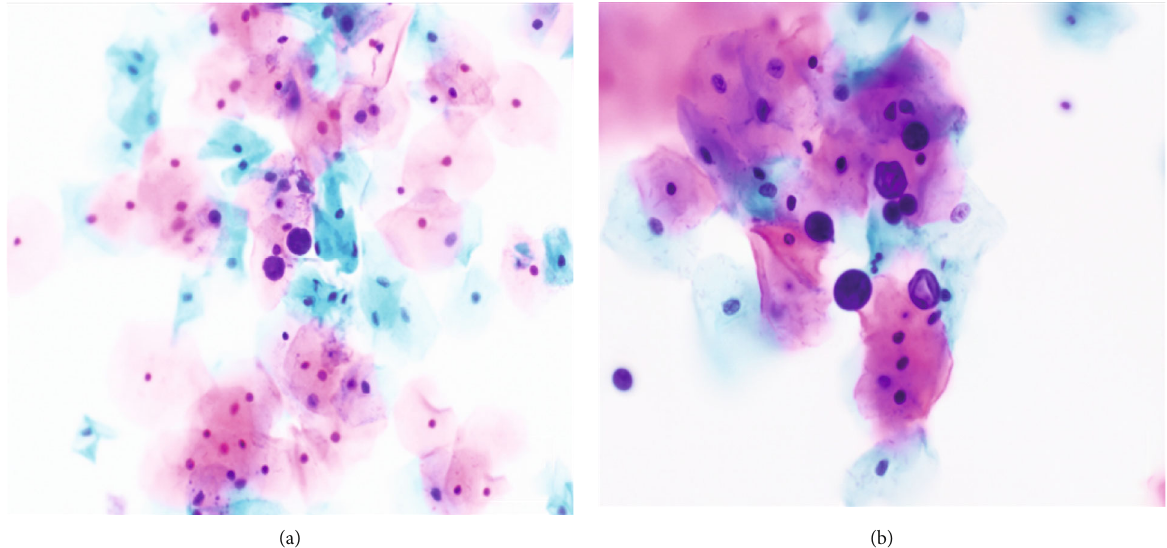
Figure 1: (a) Two large (10 to 30 μ m) fungal organisms at intermediate magni fi cation. (b) Multiple large (10 to 30 μ m) fungal organisms, some with peripheral daughter buds (2 to 4 μ m) at high magni fi cation. Background intermediate and super fi cial squamous epithelial cells provide valuable size references (cervicovaginal cytology, ThinPrep, Papanicolaou stain 400x (a), 600x (b)).